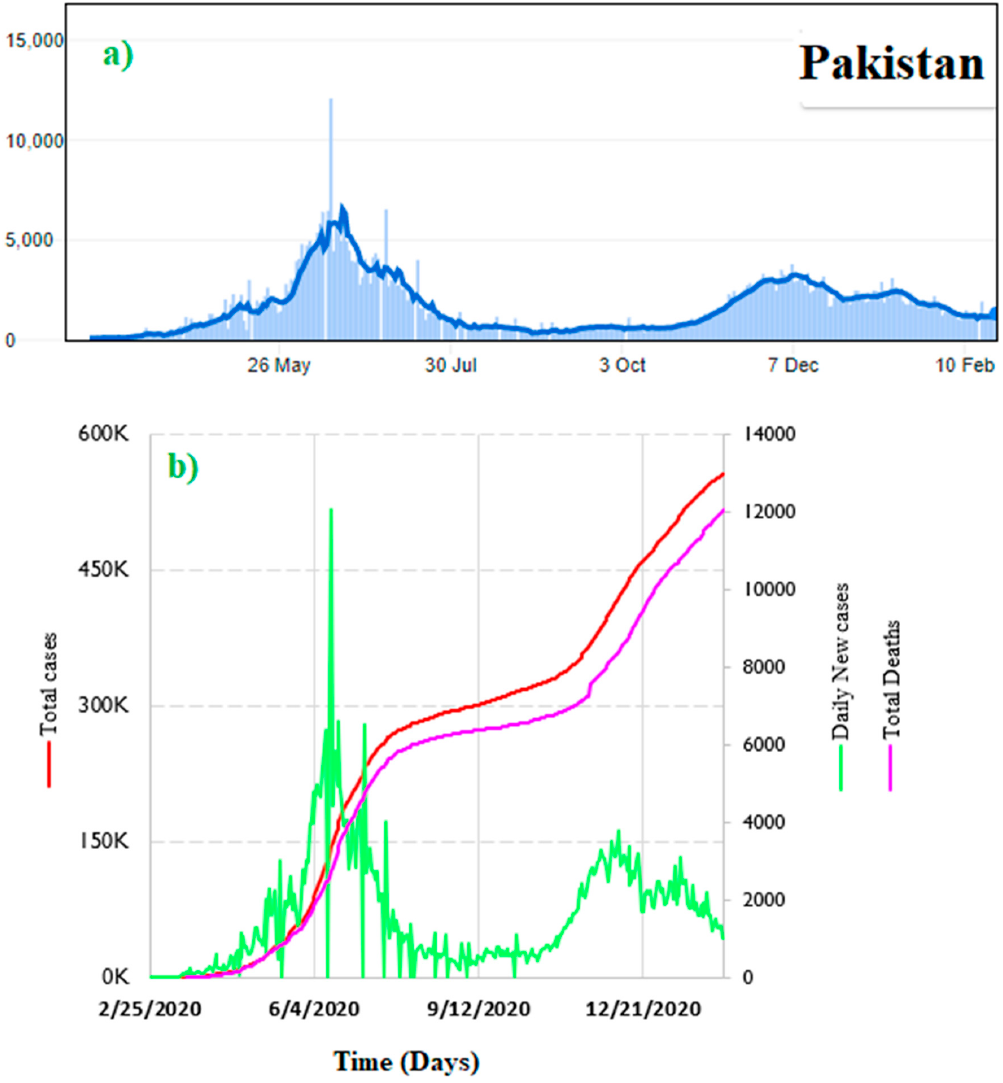
Figure 2. ( a ) The new confirmed cases of COVID-19, ( b ) the total COVID-19 cases, new cases, and total deaths in Pakistan during the period February 2020–February 2021.